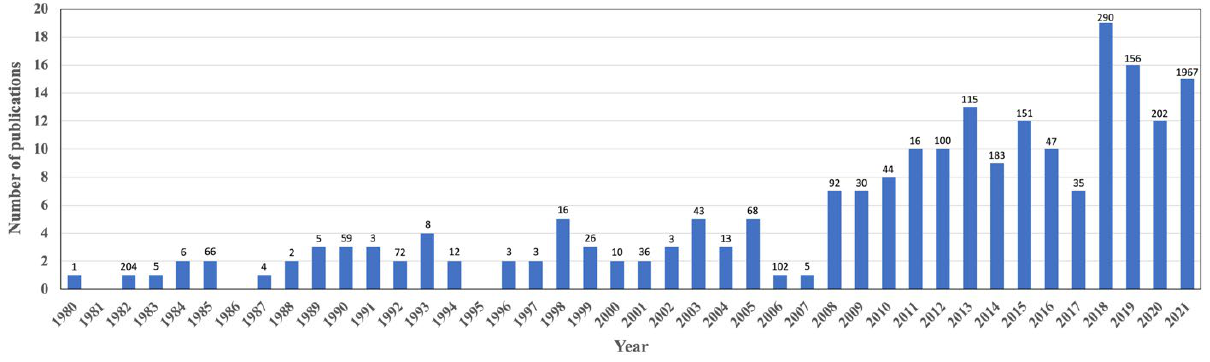
Figure 2. Distribution of 216 published articles reporting 4203 pythiosis cases in humans and animals during 1980–2021. The number above each bar graph indicates the total reported cases in each respective year.